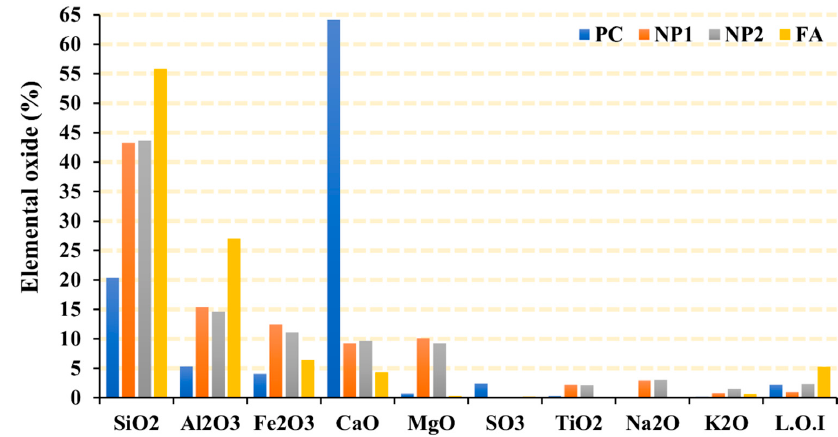
Figure 2. Chemical composition of PC and powders.